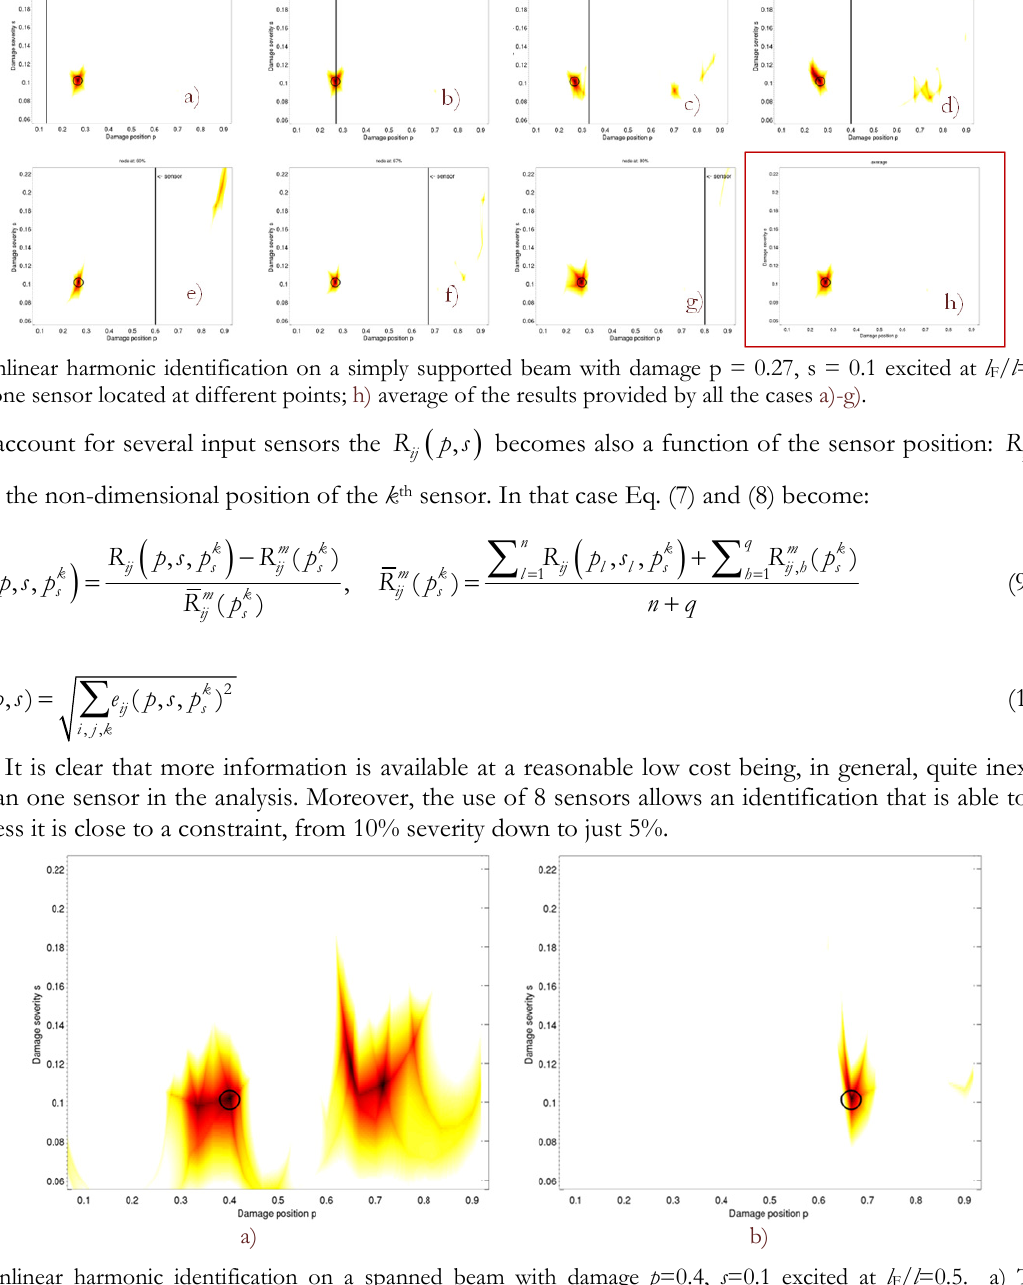
Figure 8: Nonlinear harmonic identification on a spanned beam with damage p =0.4, s =0.1 excited at l F / l =0.5. a) Three mode identification; b) Four mode